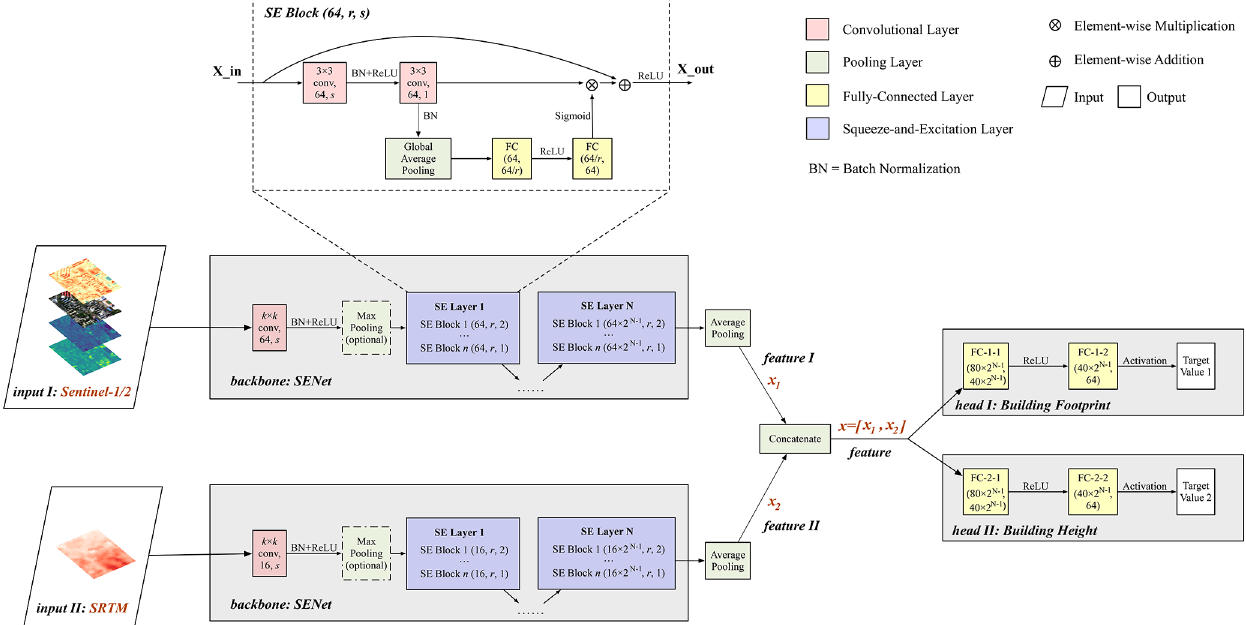
Figure 3. The architecture of the CNN deployed in this work. The convolutional layer is parameterized by k × k conv, c , s , where k is the kernel size, c is the number of output channels and s is the stride. For initial convolution used in the backbone part, k = 3, s = 1 is chosen for the cases of 100m and k = 7, s = 2 is chosen for the cases of 250, 500 and 1000m. The max-pooling layer is only used for the cases of 500 and 1000m. The fully connected layer is parameterized by D in , D out , where D in is the input dimension and D out is the output dimension. The SE block part is parameterized by C in , r , s , where C in is the number of input channels, r is a reduction ratio (Hu et al., 2018) for the fully connected layer ( r = 16 in this work) and s is the stride of convolution. The number of SE layers denoted by N is chosen as 4 for the case of 1000m and 3 for other cases (for the case of 100m, the stride of the first SE block in the first SE layer is chosen as 1). The number of SE blocks in each SE layer denoted by n is chosen as 1 for all